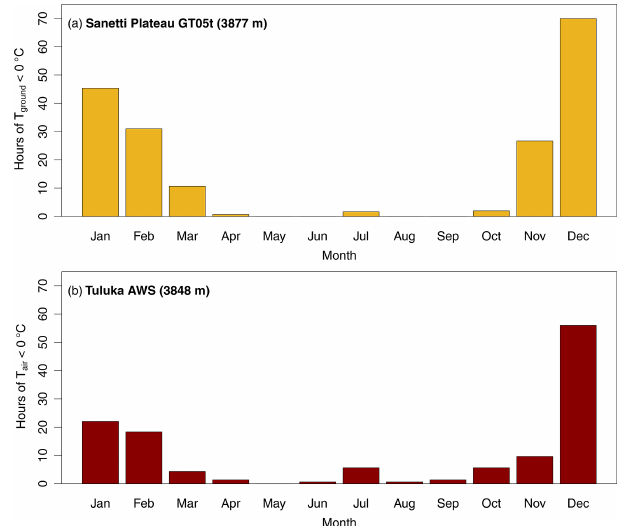
Figure 7. (a) Hours of ground frost ( T ground < 0 ◦ C) per month (3-year mean, 2017–2020) at 2cm depth on the southern Sanetti Plateau as measured by data logger GT05t. (b) Hours of T air below 0 ◦ C per month (3-year mean, 2017–2020) at the Tuluka AWS. Note that frost occurs predominantly during the dry season “Bega” from November to